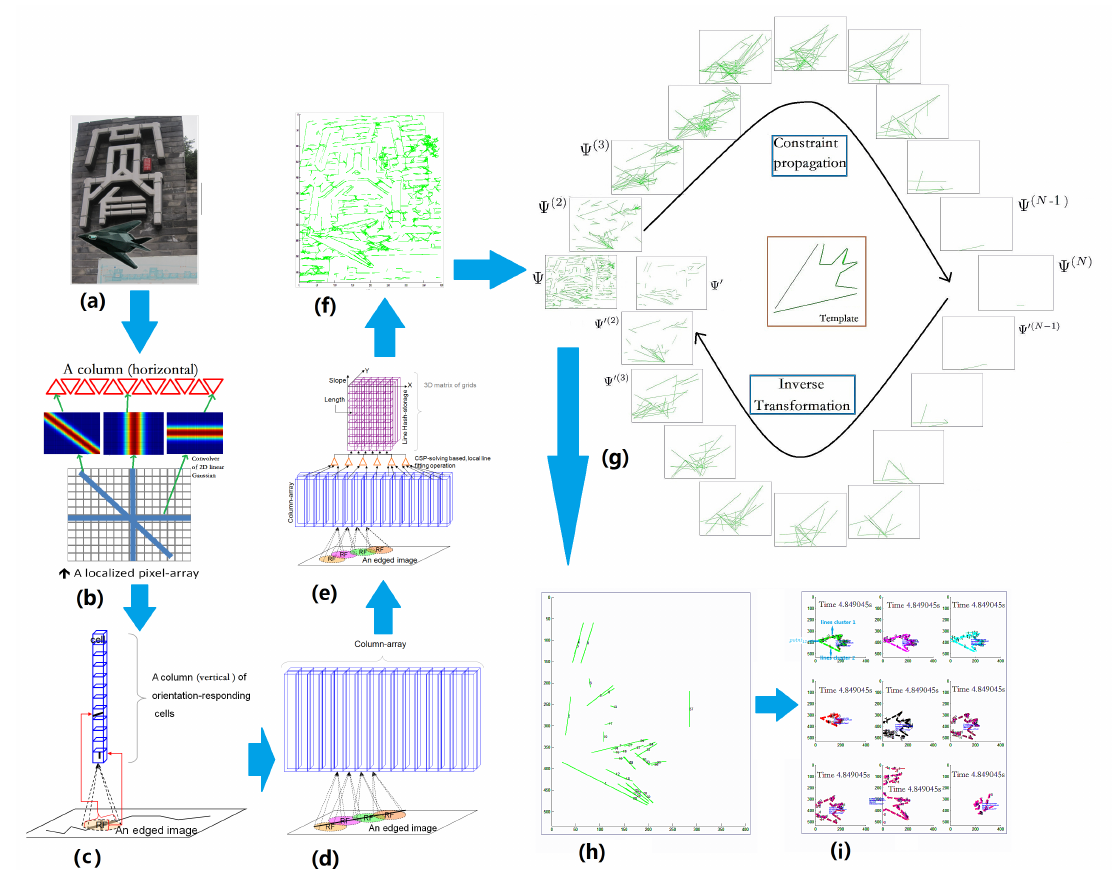
Figure 1. Architecture. ( a ) is the input image; ( b ) shows a basic functional unit. The slopes of linear stimulus for which these cells are responsible are different and exclusive. The response value of a cell is determined by its sensitive linear stimulus length and position, which can be implemented by a real-time convolver of a 2D linear Gaussian function. ( c ) A column of orientation-responding cells. A primary visual cortex-inspired column is composed of dozens of orientation-sensitive cells. They share a common receptive field on an image, but each cell is in charge of a specific and exclusive linear stimulus occurring in the receptive field (RF). ( d ) Column-arrays. A long line might pass through multiple RFs. Perceiving it can be seen as a fitting operation, subjected to multiple constraints provided by those RFs. A number of columns can be orderly arranged to form an array. The receptive fields of these columns might be partially overlapped. This array processes the image in a compound receptive field of all columns. ( e ) The architecture. At the top of column array, there is a 3D matrix of grids. Each grid is a register for storing a line. X and Y index the line’s center position, and the vertical position of the grid indexes the line’s slope, and the value stored in a grid is the line’s length. ( f ) An example of line extraction by the proposed architecture. ( g ) The process of constraint propagation. ( h ) Lines resulting from the constraint propagation. ( i ) The object estimation by verification. The location, scale, and orientation of the object can be verified through searching path. The top nine paths satisfying the geometric constraints of Γ were found. Each path represents an estimation of the object. It is obvious that our method not only efficiently detected the object but also estimated the location, scale, and orientation of the